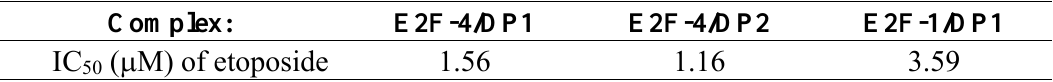
Table 3. IC of reporter gene transcription of 50